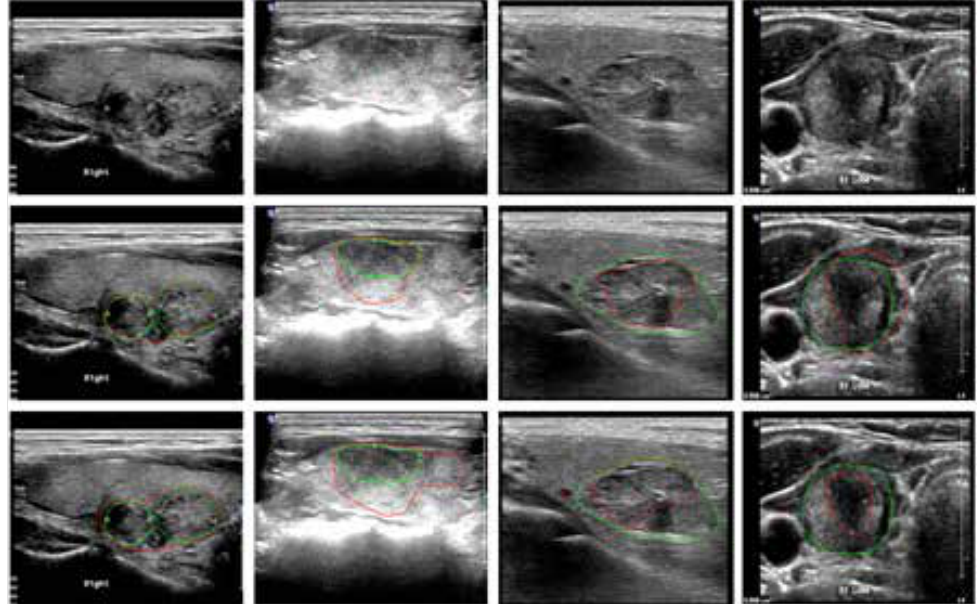
Figure 10 Cases of incorrect segmentation for thyroid nodule images by the pre-trained convolutional neural network (PCNN) and convolutional neural network without pre-training (NCNN), respectively. The original images are shown in the first row; the segmentation results of the PCNN and the NCNN are shown in the second row and the third row, respectively, where the green is the ground truth, the red is the accurately automatic